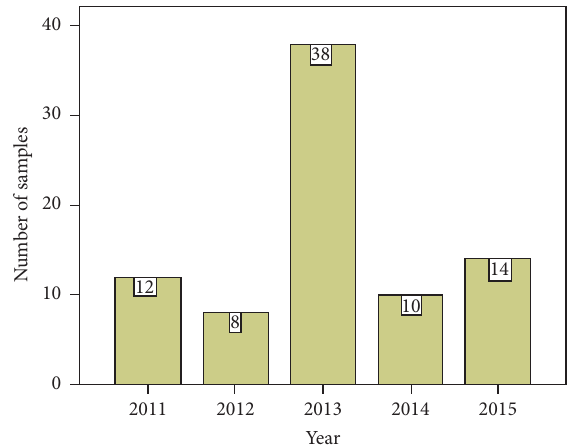
Figure 1: Frequency of sampling edible salt per